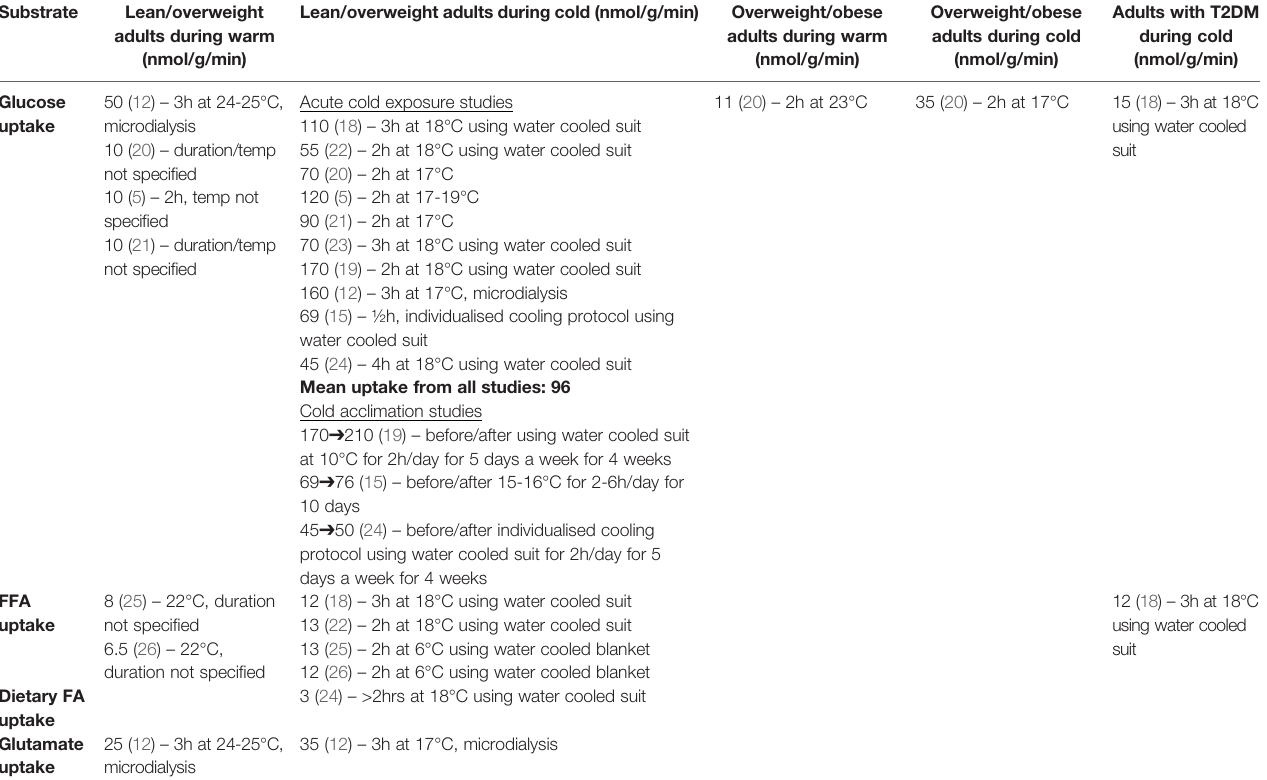
TABLE 1 | Quanti fi cation of substrate utilization by human